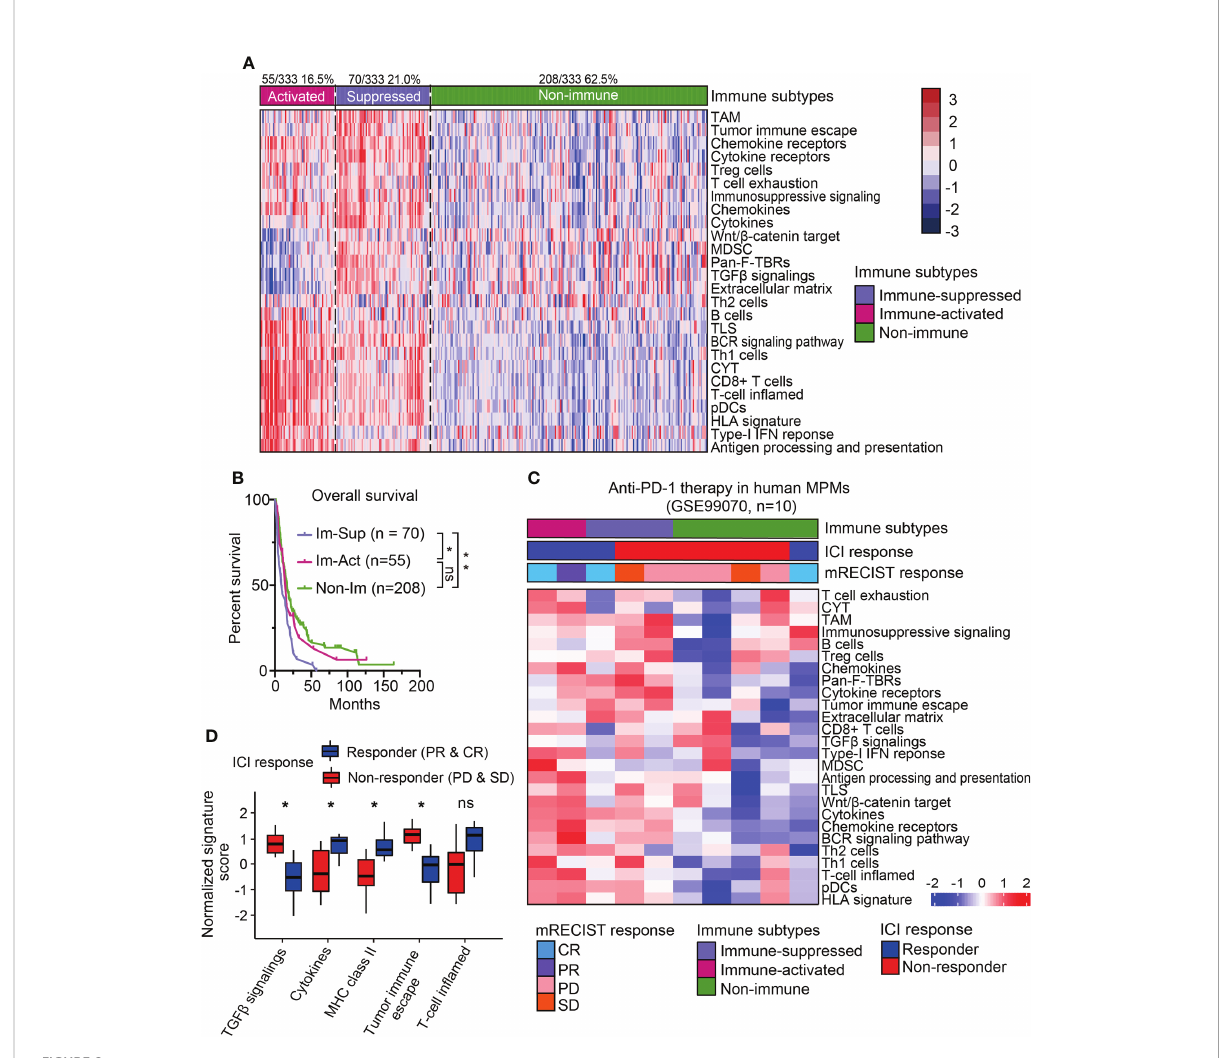
FIGURE 2 Sub-classi fi cation and dissection of MPM immune microenvironment. (A) The immune subtype was further subdivided into immune-activated (70/125, 21.0%) and immune-suppressed (55/333, 16.5%) MPMs, using nearest template prediction (NTP) analysis with signatures covering 26 immune- and TME-related signatures. TAM, Tumor-associated macrophage; MDSC, Myeloid-derived suppressor cell; TLS, Tertiary lymphoid structure; CYT, Cytolytic activity. pDCs, Plasmacytoid dendritic cell; Pan-F-TBRs, Pan fi broblast TGF- b response signature. (B) Kaplan-Meier survival analyses of overall survival in the integrated MPM cohort with different immunological subtypes. **, p < 0.01; *, p < 0.05; n.s., Not signi fi cant. (C) The heatmap showing the expressions of 26 immune- and TME-related signatures in the pretreatment human MPM cohort upon the anti-PD-1 treatment. The dataset was classi fi ed using the same approach as previously shown in Figure 2A. Top column shows the corresponding immune subtype and mRECIST response of each case. ICI, Immune checkpoint inhibitor. (D) The normalized signature score of immune characteristics in anti-PD-1 response and non-response subgroups. CR, Complete response; PR, Partial response; PD, Progression disease; SD, Stable